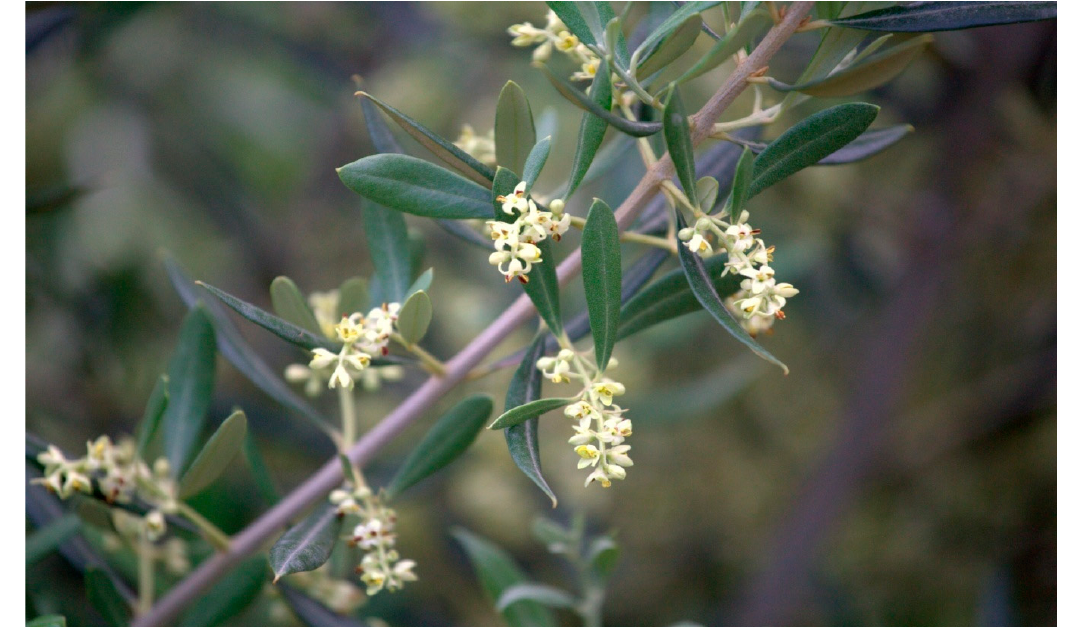
Figure 2. Leaves and inflorescences on bearing shoot of ‘Lecciana’.